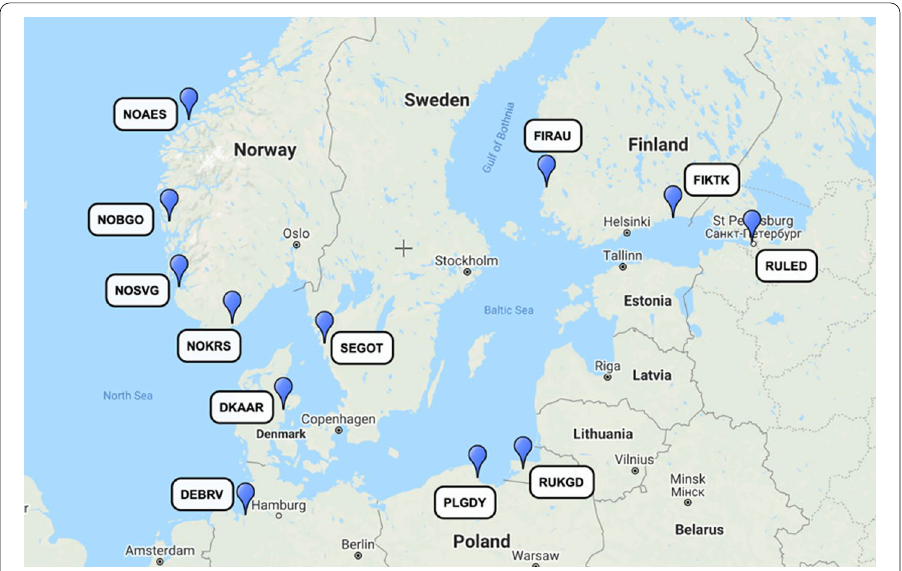
Fig. 1 Ports location in the Baltic instance of the LINER-LIB benchmark suite ( Brouer et al.